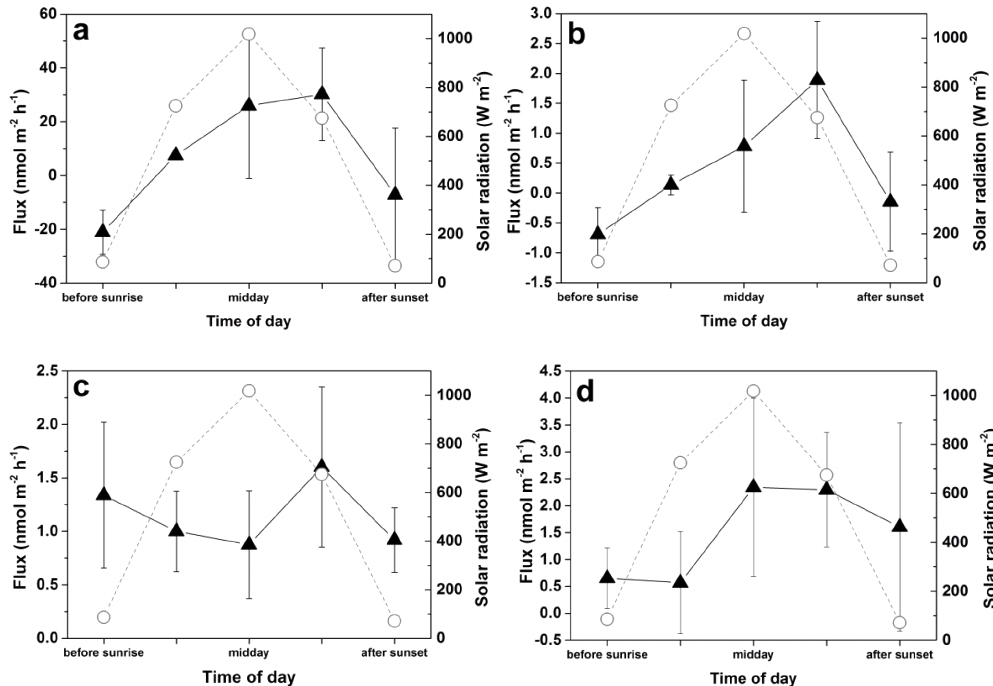
Figure 2. Diurnal variation of mean halocarbon fluxes (triangles) from seagrass meadows during periods of air exposure in summer 2011 ( a : CH 3 Cl, b : CH 3 Br, c : CH 3 I, d : CHBr 3 ). Error bars refer to standard deviations. Circles are solar radiation values. Note that the scales on the y axis are different for each